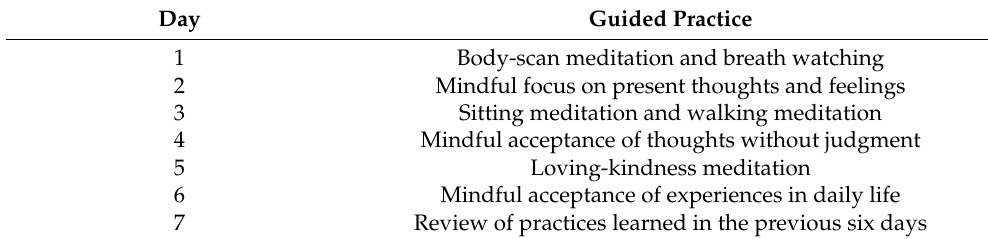
Table 1. The contents of daily mindfulness meditation